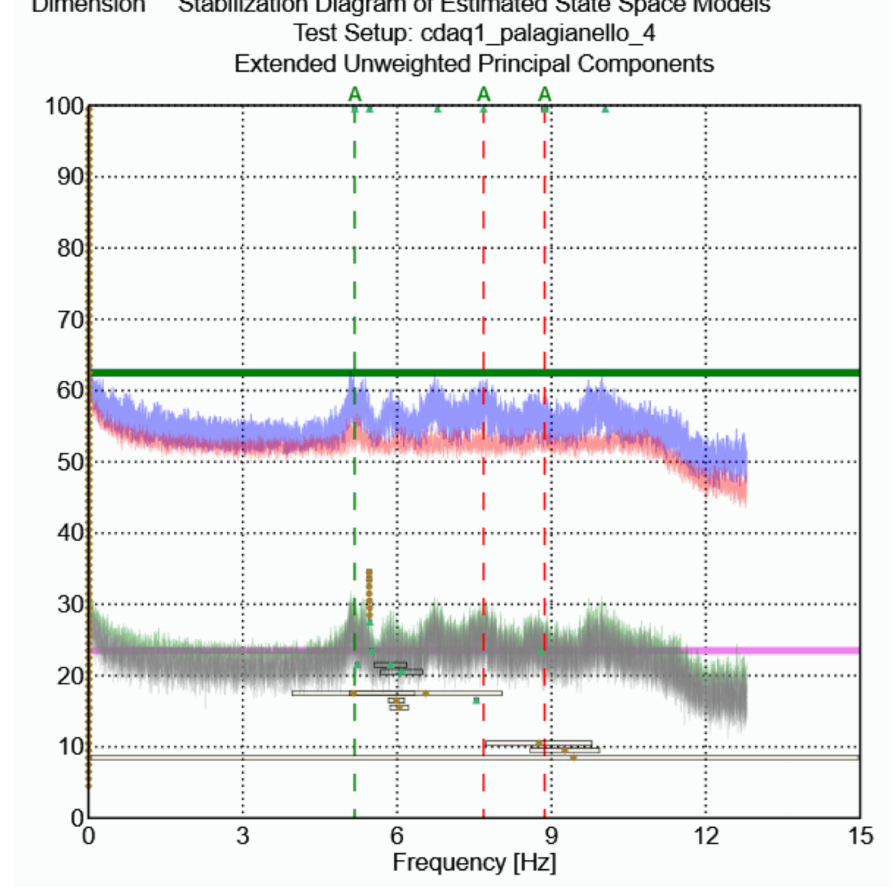
Figure 10. Results of the SSI-UPC identification analysis performed on the data acquired during Test 1.